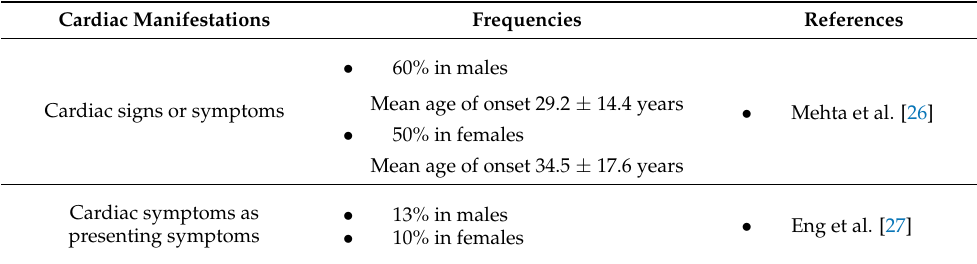
Table 1. Frequency of cardiac symptoms in